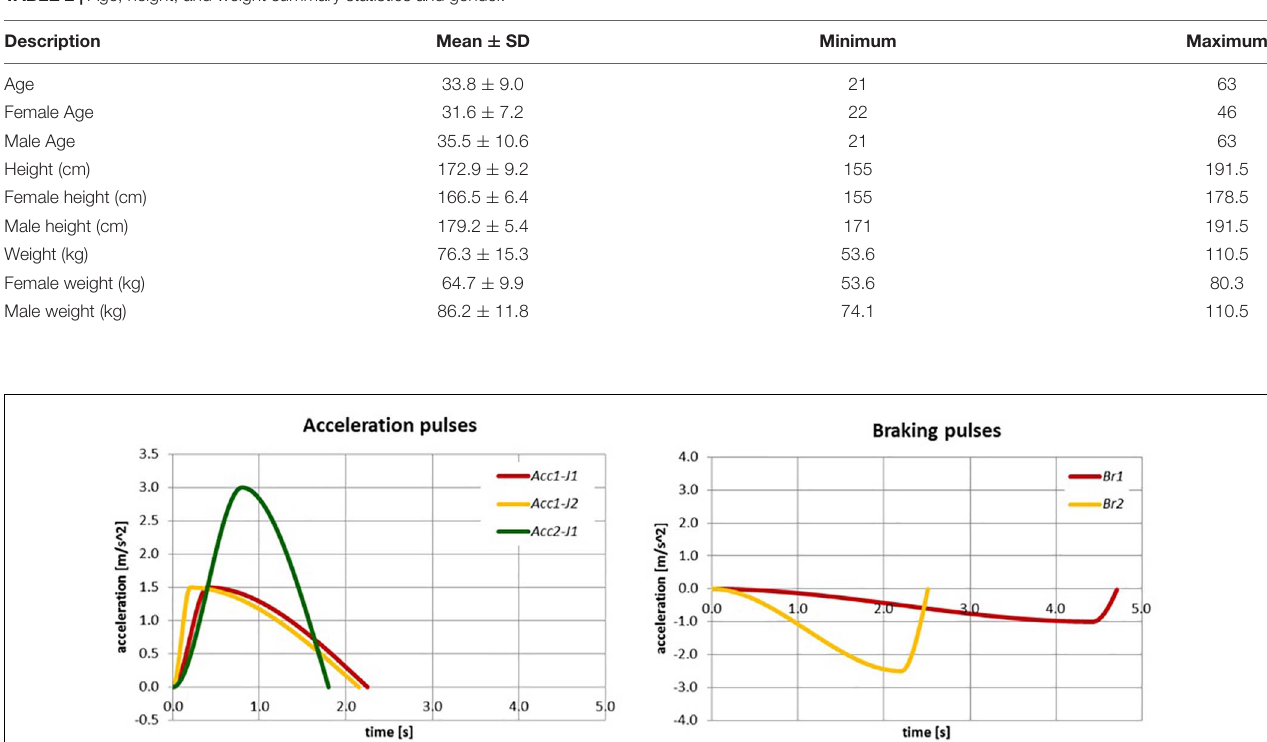
TABLE 2 | Age, height, and weight summary statistics and gender.